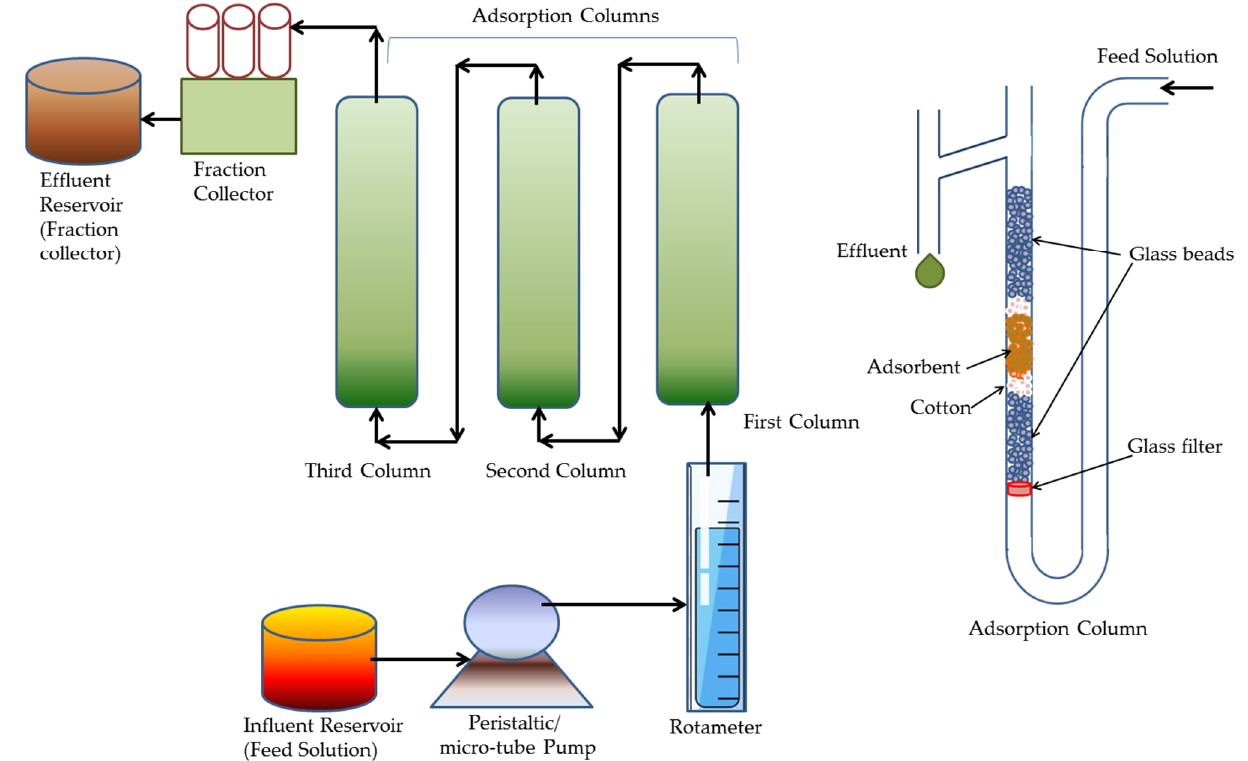
Figure 8. Schematic representation of experimental set-up for fixed-bed adsorption column. Artwork developed from References [97–99].